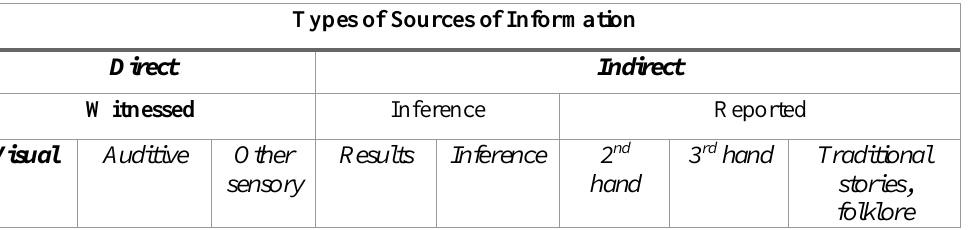
Table 2. Evidentiality: source of information